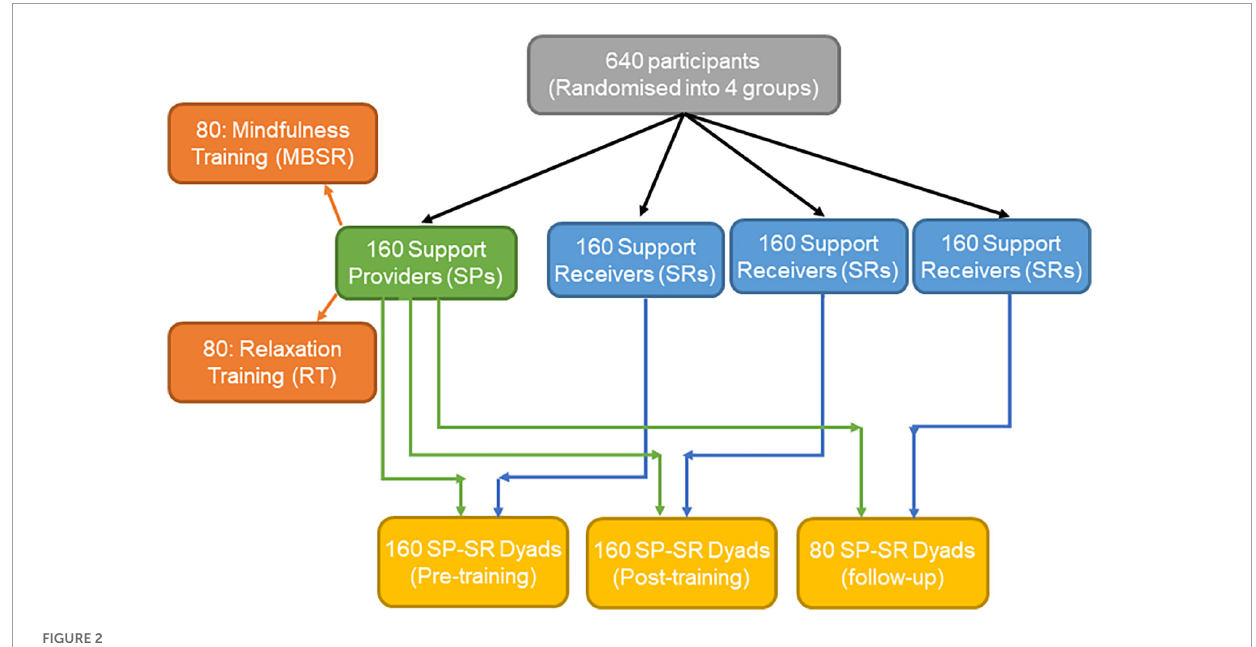
FIGURE2 Schematic representation of the randomization